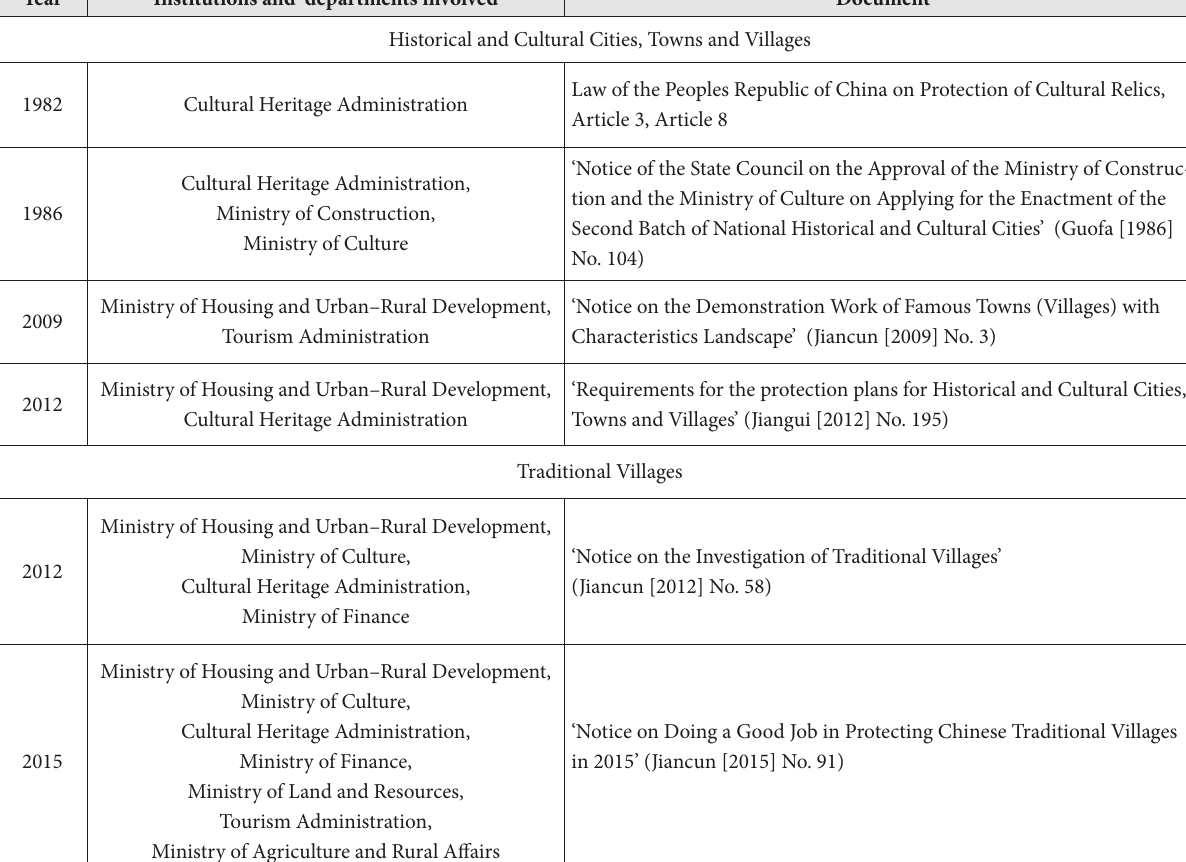
Table 3 The departments participated in the management of rural heritage (Source: the